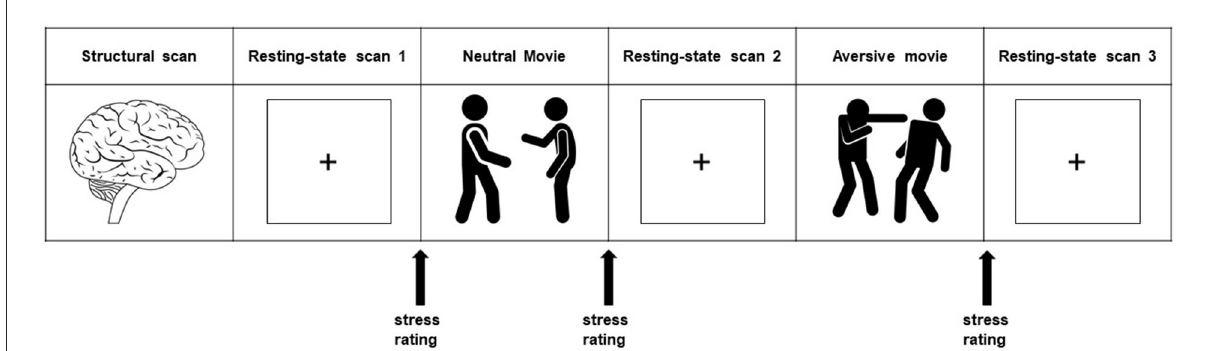
FIGURE1 Experimental design. The whole protocol consists of a series of scans of which we used the structural scan and the three resting-state scans (8:30minutes each) for our present study. Resting-state scan 1 is used to study the brain at rest, and is referred to as the baseline resting-state scan. Stress induction took place with a highly aversive movie clip (2:20minutes), with a self-referential eyewitness instruction. The neutral movie clip (2:20minutes) served as a control condition. Stress-induced changes in connectivity strength were investigated using the resting-state scans directly after these movie clips (stress minus neutral: resting-state 3 minus resting-state 2). Subjective stress levels were assessed with an 11-point rating scale. Heart rate (in beats per minute) was measured continuously during